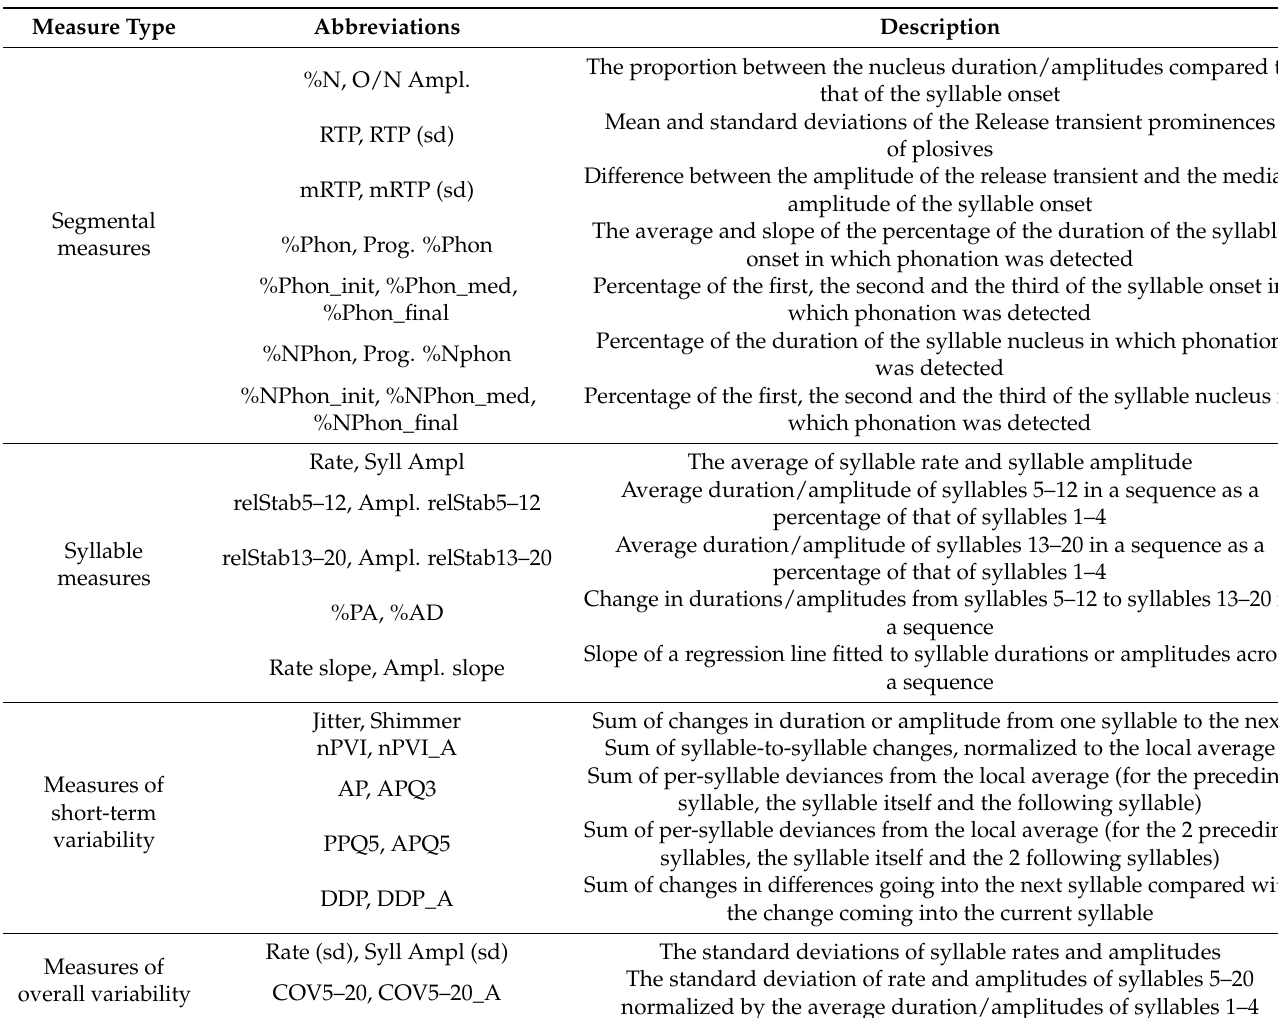
Table 2. The duration and amplitude measures used to quantify diadochokinetic (DDK)